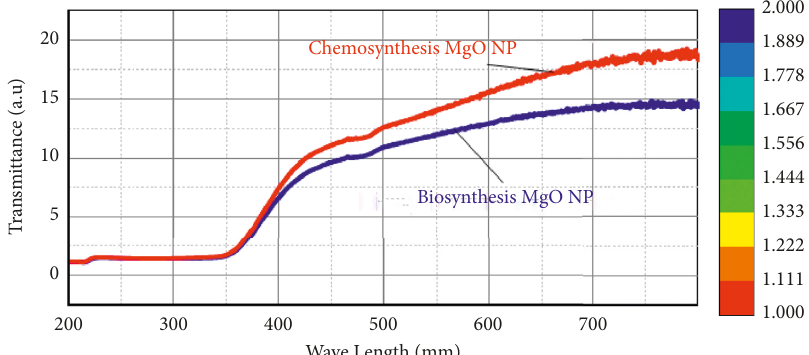
Figure 5: Transmittance measured by UV-Vis of biosynthesized and chemosynthesized magnesium oxide (MgO) nanoparticles derived from Datura stramonium leaves extract.